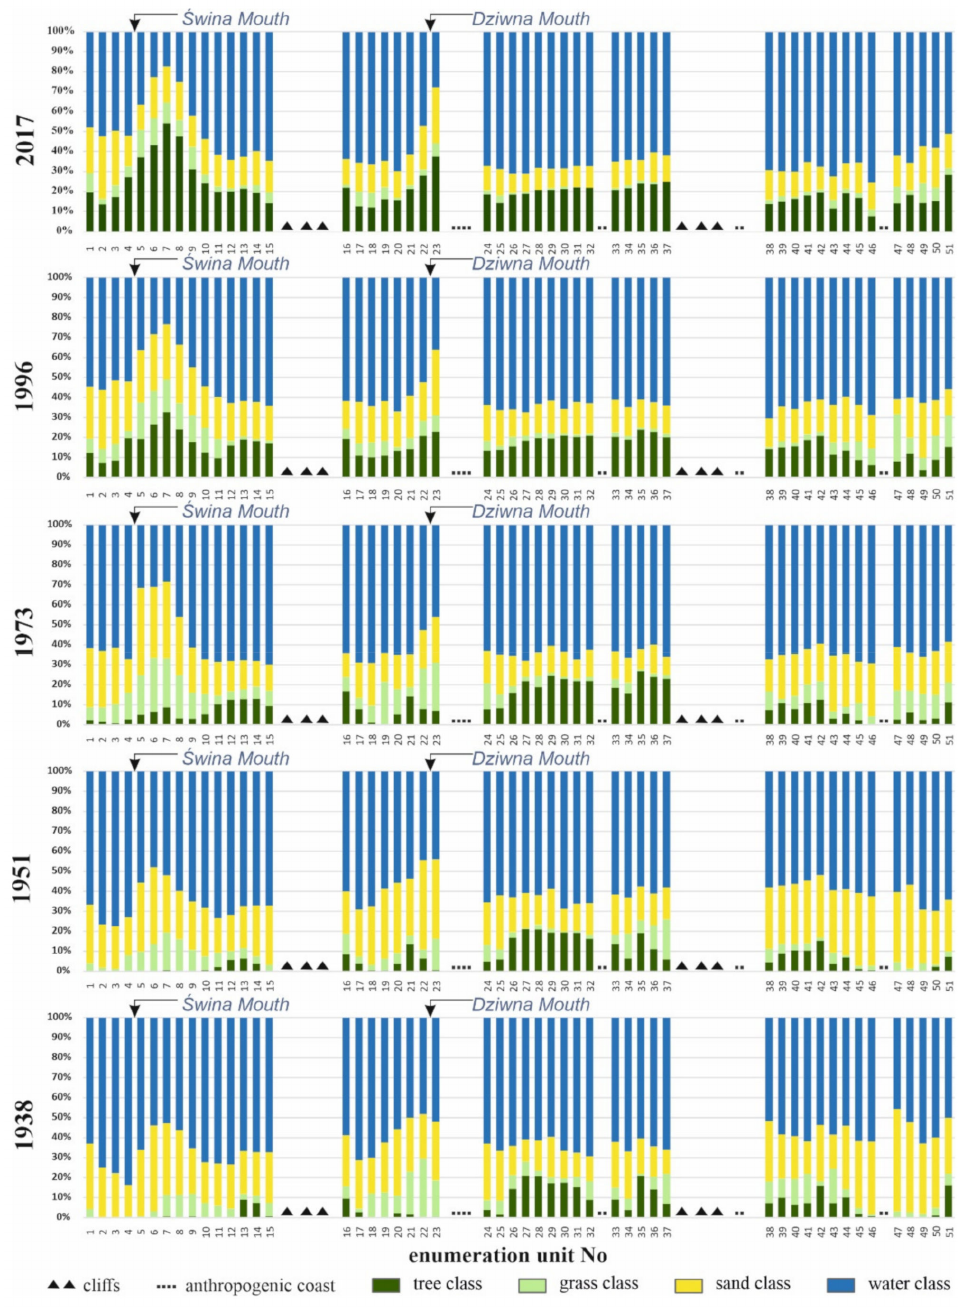
Figure 4. Percentage share of each